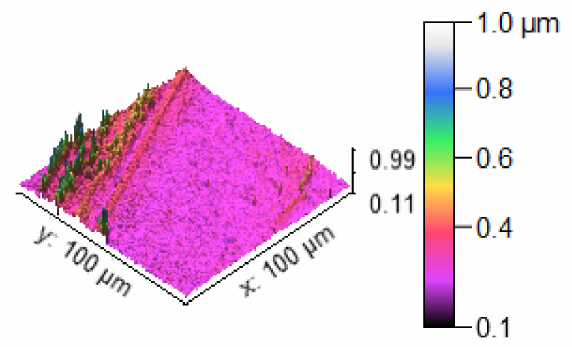
Figure 16. Three dimensional (3D) profilometric image (S-4).